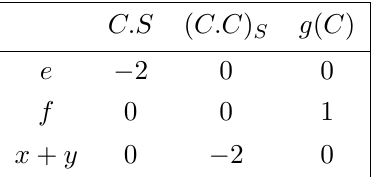
Table 1 . Curve classes in the M-string